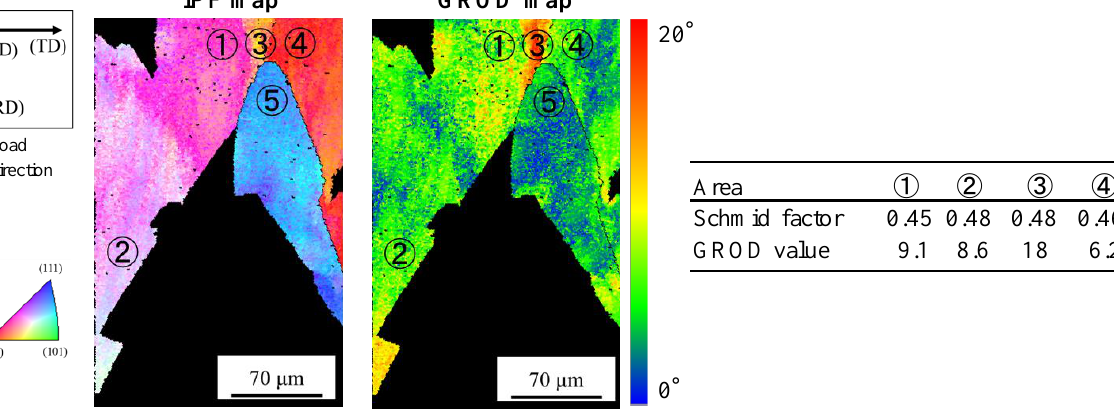
Figure 14. IPF map and GROD map of the area that shows the high GROD value in Figure 13c, and Schmid factor and GROD values for each area shown in the figure.